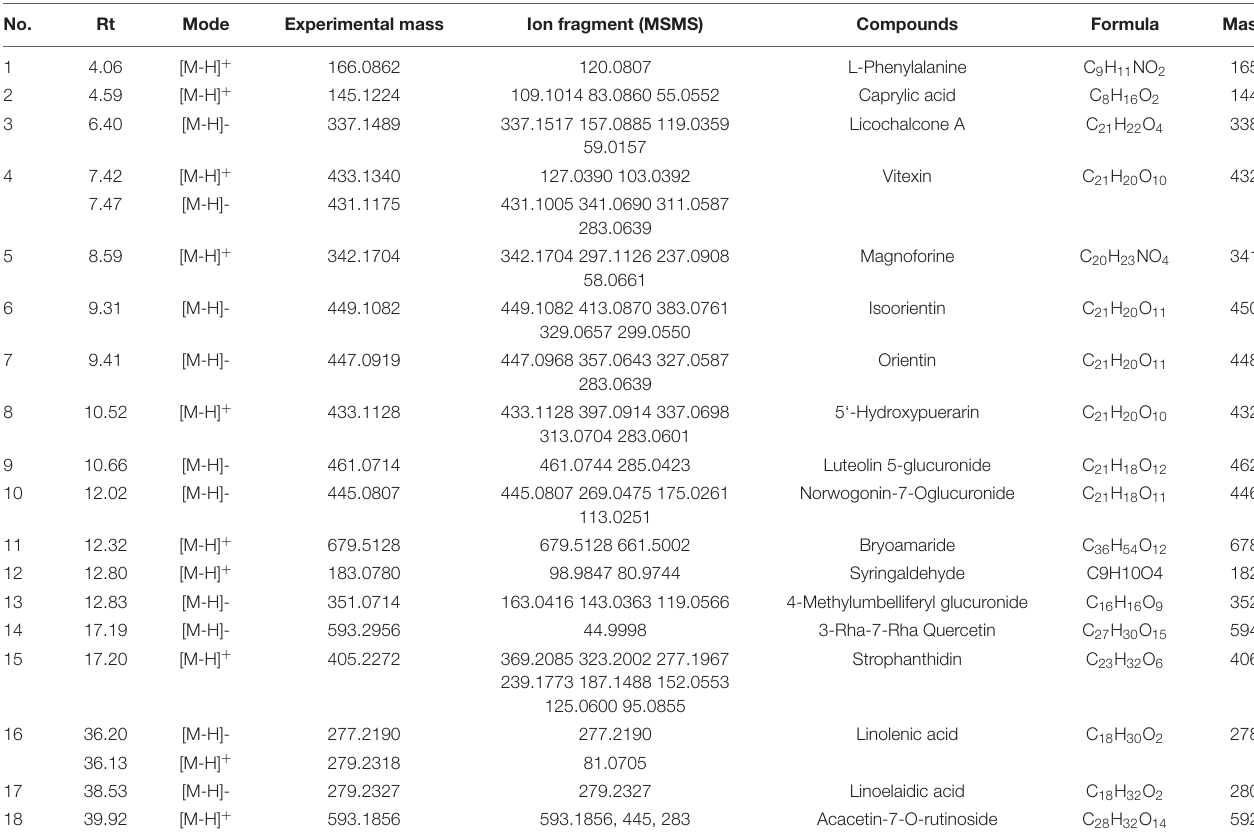
TABLE 2 | Characterization of chemical constituents of the aerial parts of Adonis coerulea identified by ultra-performance liquid chromatography tandem mass spectrometry (UPLC-MS/MS).